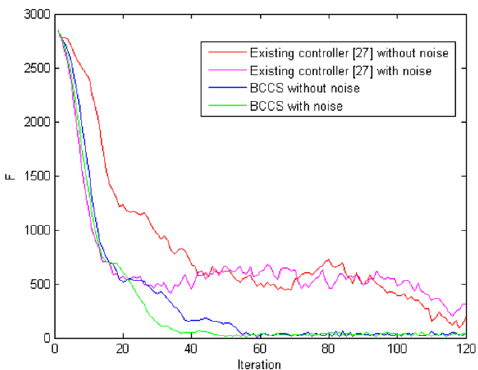
Figure 16. The F evolution of two methods without and with noise for aggregation. The red and purple lines are for the controller without and with noise in Reference [27], respectively. The blue and green lines are for BCCS without and with noise, respectively.